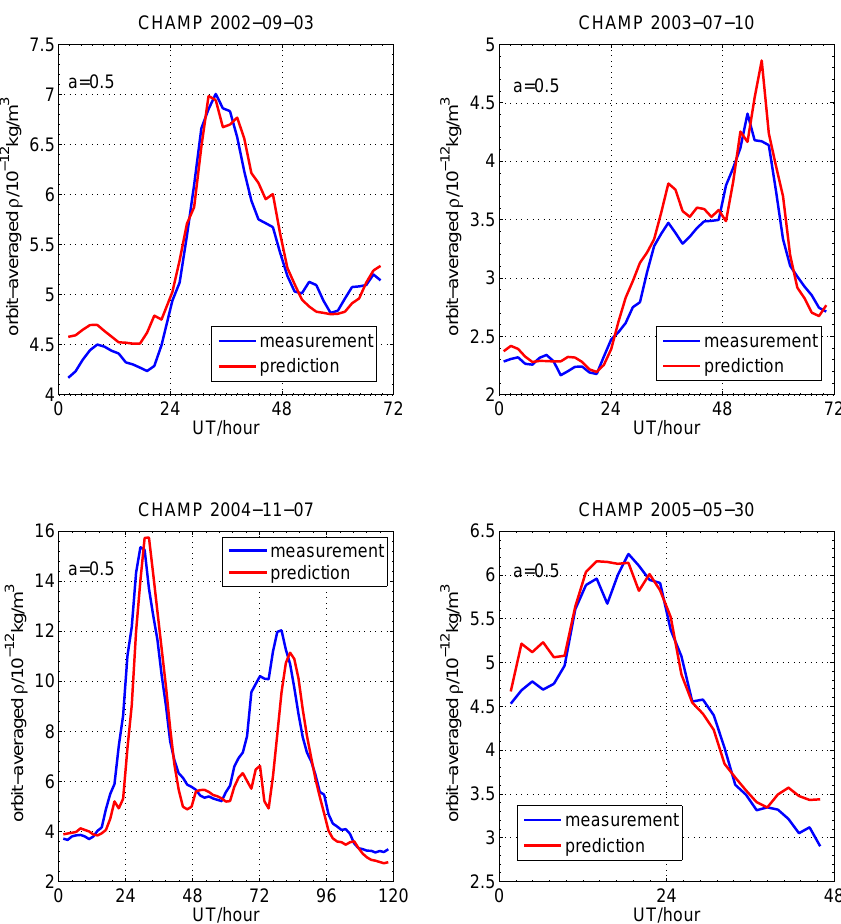
Fig. 5. Comparison between CHAMP orbit-averaged density measurements and predictions of our model using a density delay time of 3h and a = 0 . 5 for four storms during 2002 to 2005. 3 to 5 September 2002, 10 to 12 July 2003, 7 to 9 November 2004, and 30 to 31 May 2005. The 2002 and 2003 storms are CIR driven storms, and the 2004 and 2005 storms are ICME-driven storms. The blue and red curves represent the CHAMP observations and model predictions,